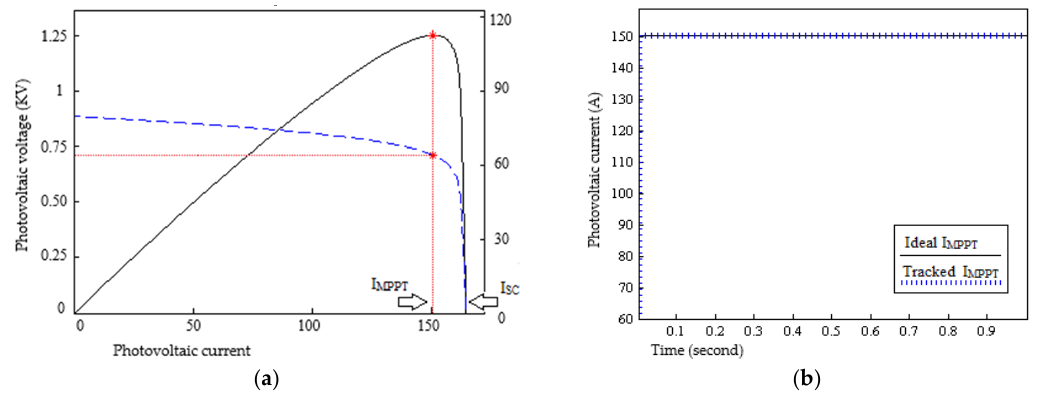
Figure 11. ( a ) Generated power and voltage vs. current under standard condition; and ( b ) optimum current point tracking. Table 3. One solar module profile (at 25 ˝ C and 1000 W/m 2